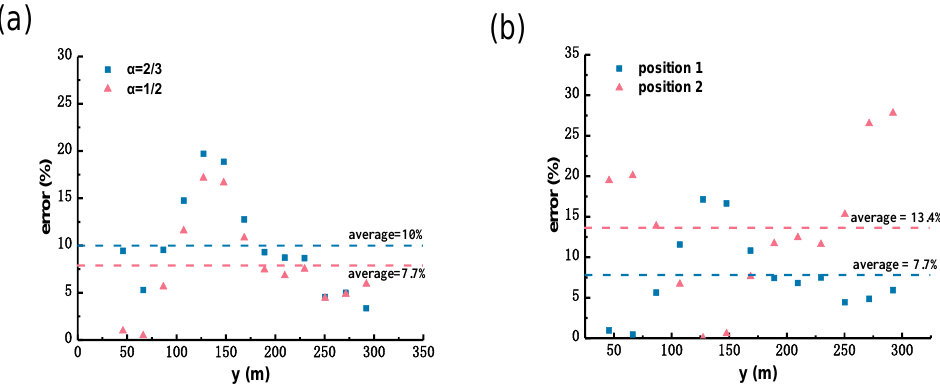
Figure 7. Parameter sensitivity analysis: ( a ) the effect of the cross-section characteristic coefficient α on the estimation error of unit discharge at each measurement point of the cross-section with a constant survey-point position; ( b ) the effect of the survey-point position on the estimation error of unit discharge at each measurement point of the cross-section with a cross-section characteristic coefficient of 0.5.